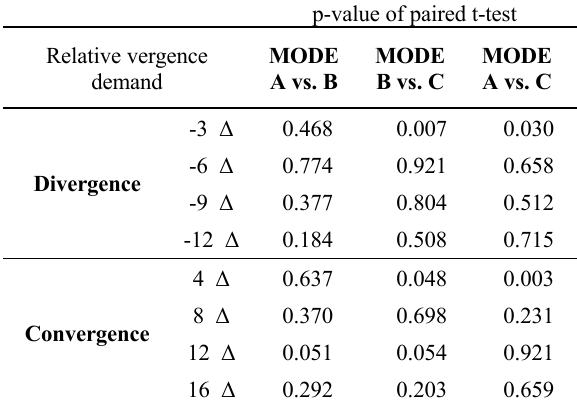
Table 3. Statistical significance of differences in the suppressive thresholds of experimental degradation modes with respect to vergence demand levels